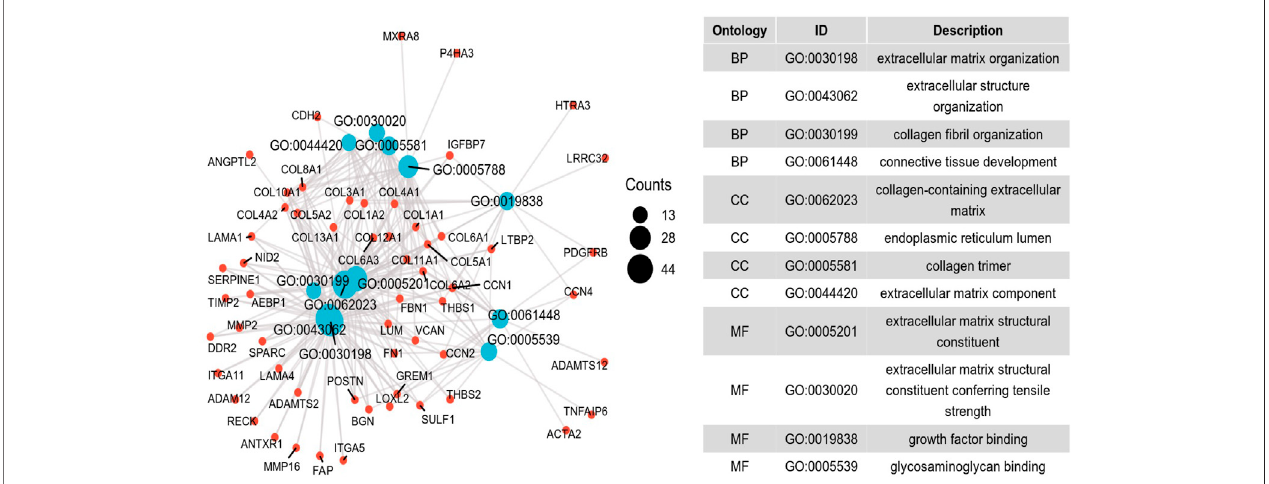
FIGURE 3 | Signi fi cant Gene Ontology terms of the top 100 genes most positively associated with INHBA , including BP (biological processes), MF (molecular function) and CC (cell component).